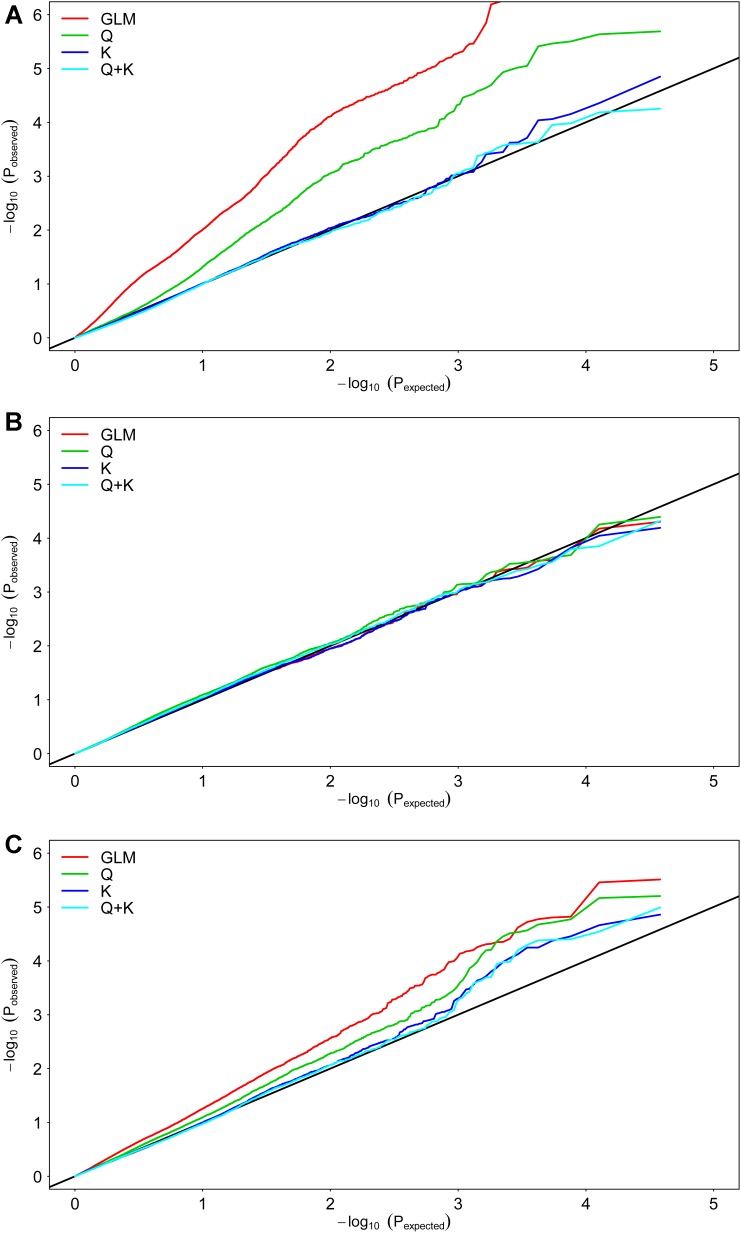
Quantile–quantile plots of estimated –log10(P) from association analysis of Cd accumulation traits in rapeseed accessions. (A) Root Cd concentration (RCC). (B) Shoot Cd concentration (SCC). (C) Cd translocation coefficient (CT). GLM considering no Q and K; Q, GLM considering Q; K, MLM considering K; Q + K, MLM considering Q and K;